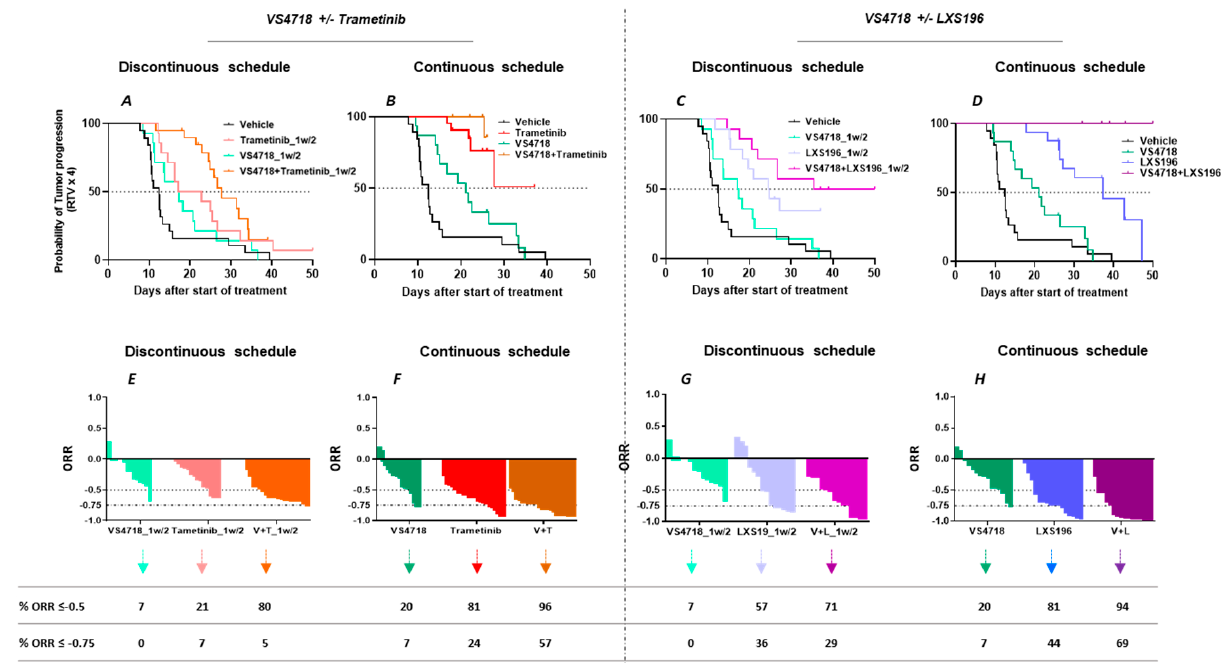
Figure 5. In vivo efficacy assessment: Probability of progression of both monotherapies and combinations ( A – D ). The probability of progression after each tested treatment; the methodology is detailed in the Materials & Methods section; the time to reach relative tumor volume (RTV) × 4 for each treated mouse has been calculated. Gehan-Breslow-Wilcoxon test is applied to evaluate significance. ORR of both monotherapies and combinations ( E – H ): In vivo efficacy of VS4718 with Trametinib or LXS196 in 3 uveal melanoma patient-derived xenografts. Overall response rate (ORR): the percentage corresponds to the mice with an ORR < − 0.5 and ORR < − 0.75. Fisher’s test is applied to evaluate significance.